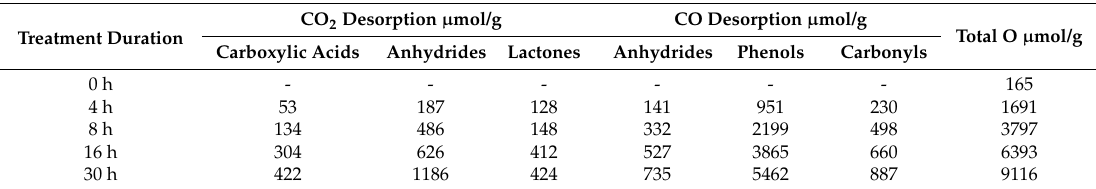
Table 2. The content of oxygen functional groups as a function of the acid treatment duration at 250 ◦ C on the samples determined from TPD profiles.